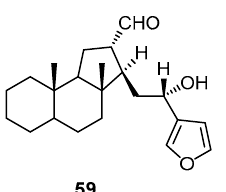
Figure 15. Chemical structure of hyrtiosal ( 59 ).